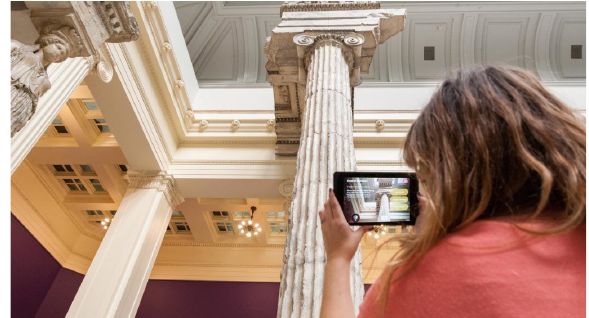
Figure 9: Application of augmented reality within the Carniegie Museum of Art. Visitors can query through the dedicated application the archaeological finds